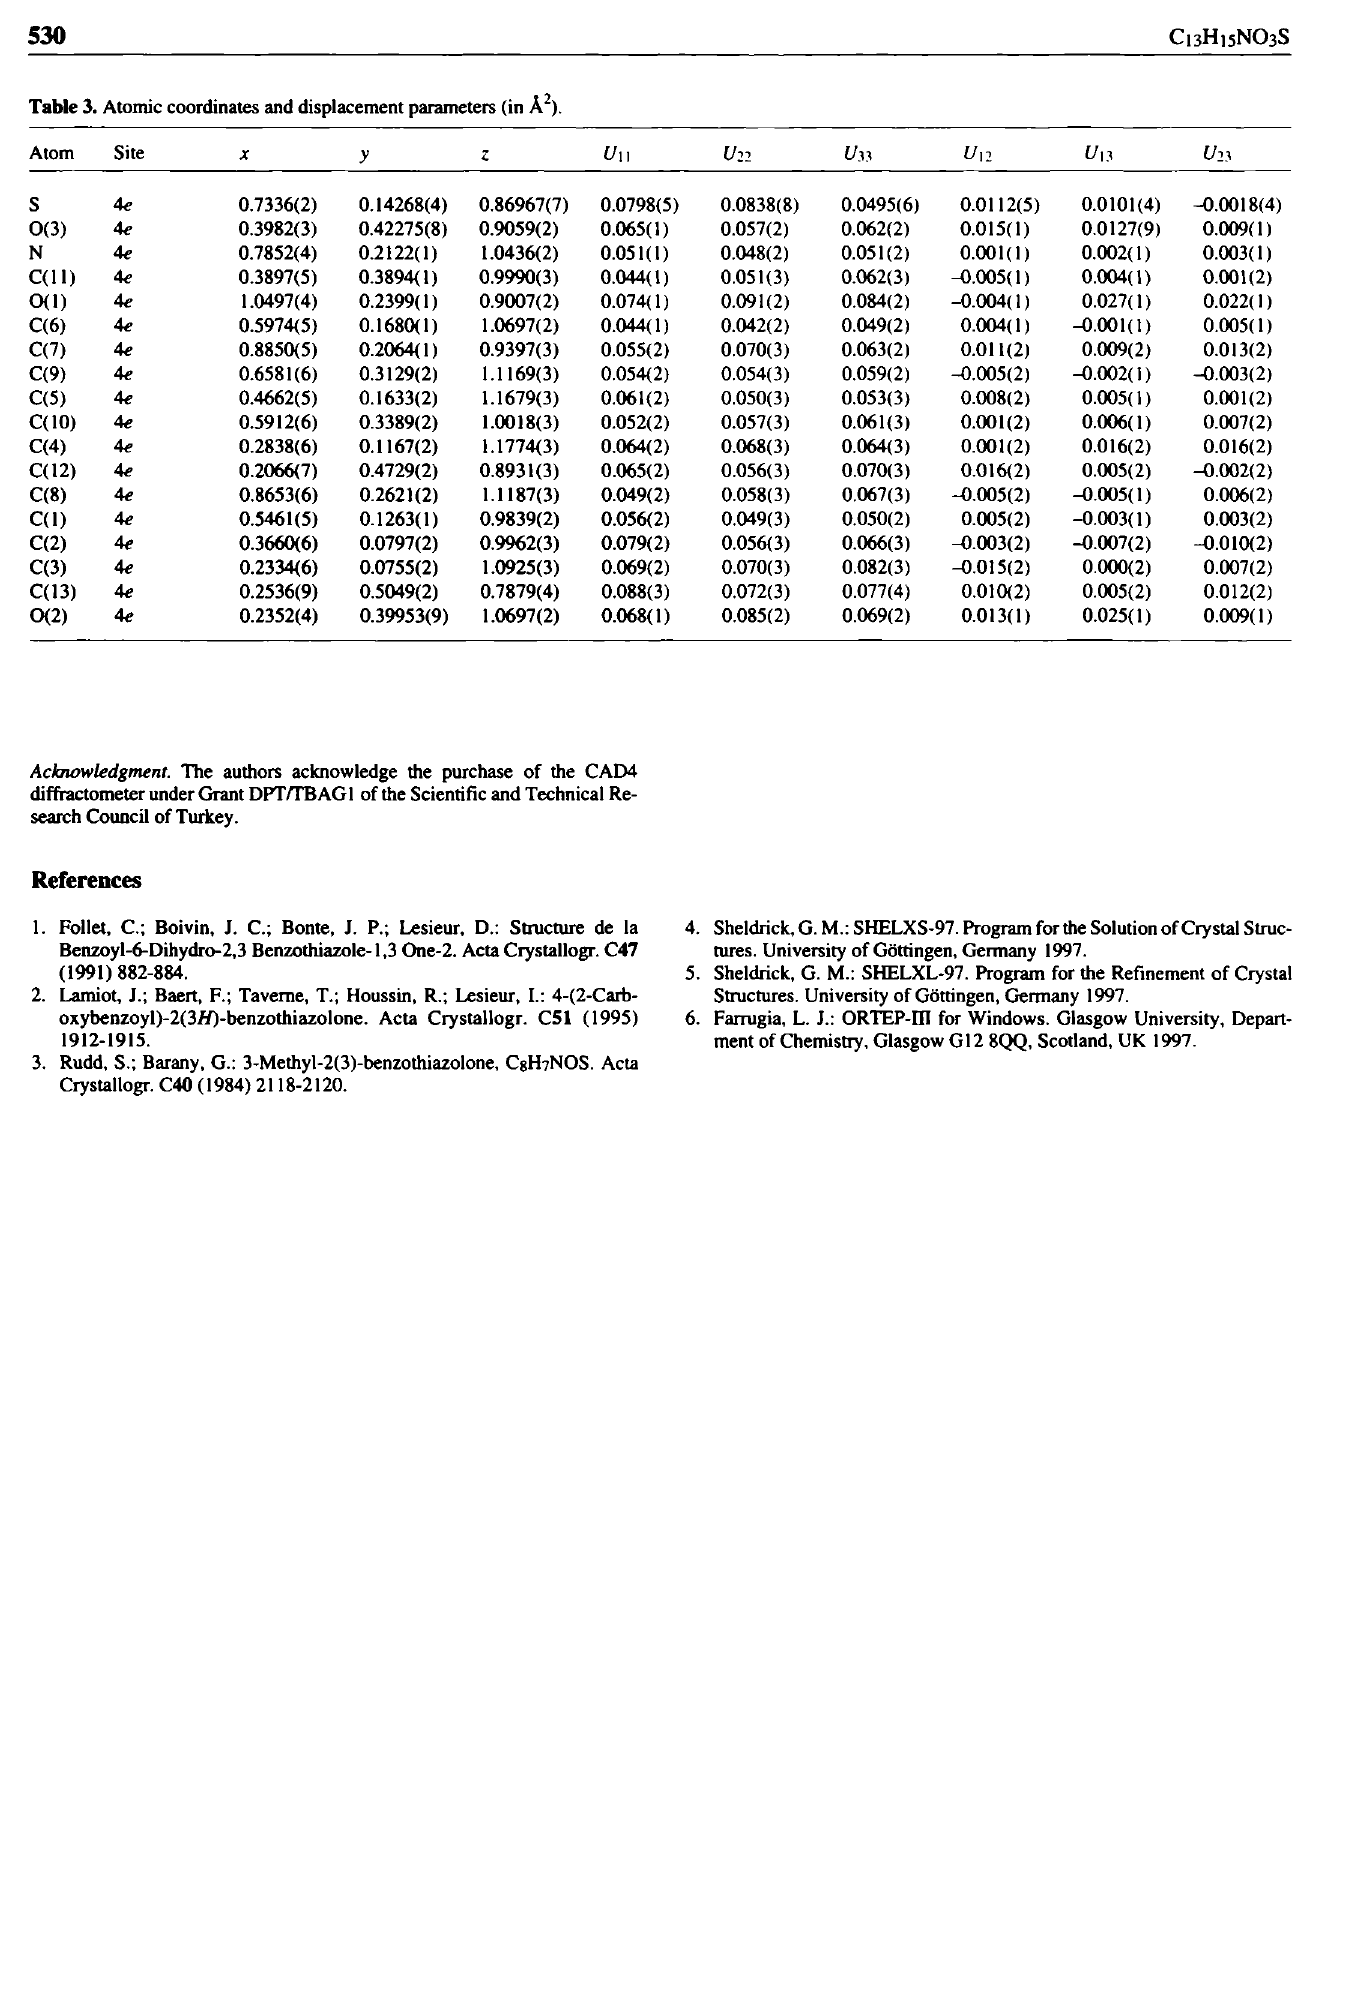
Table 3. Atomic coordinates and displacement parameters (in Â 2